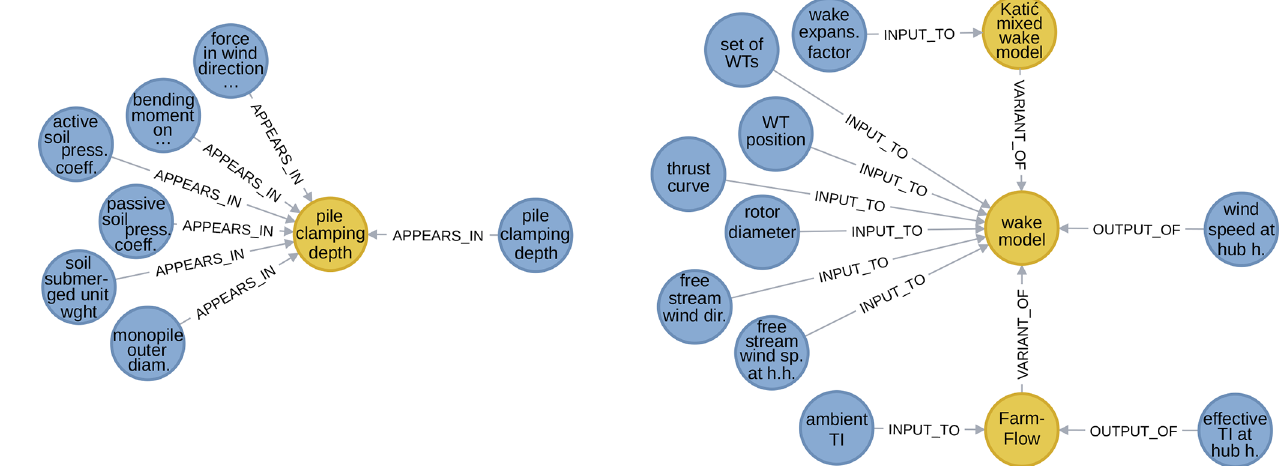
Figure 7. Excerpts from WESgraph of the subgraph of model – variable pairs.